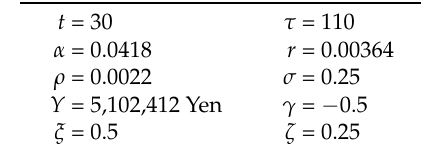
Table 1. Parameters used in the numerical simulation.